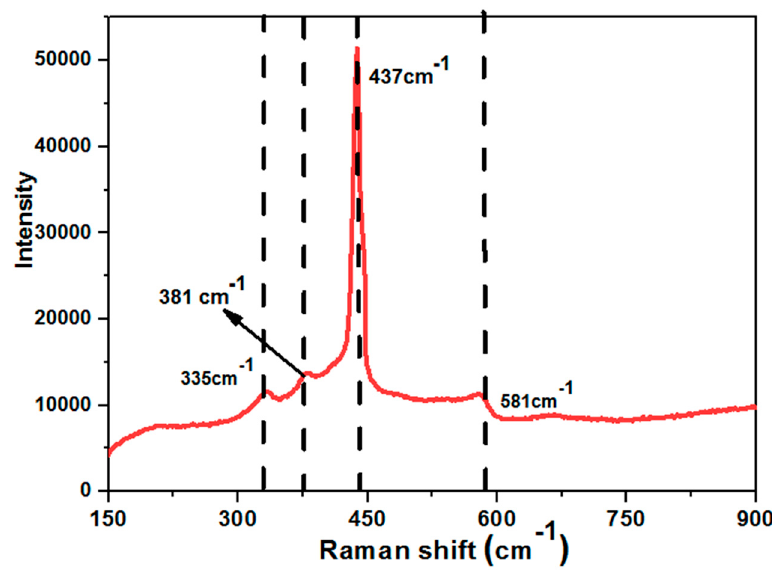
Figure 4. Typical Raman scattering spectrum of flower-shaped ZnO nanostructures directly grown on FTO substrate.